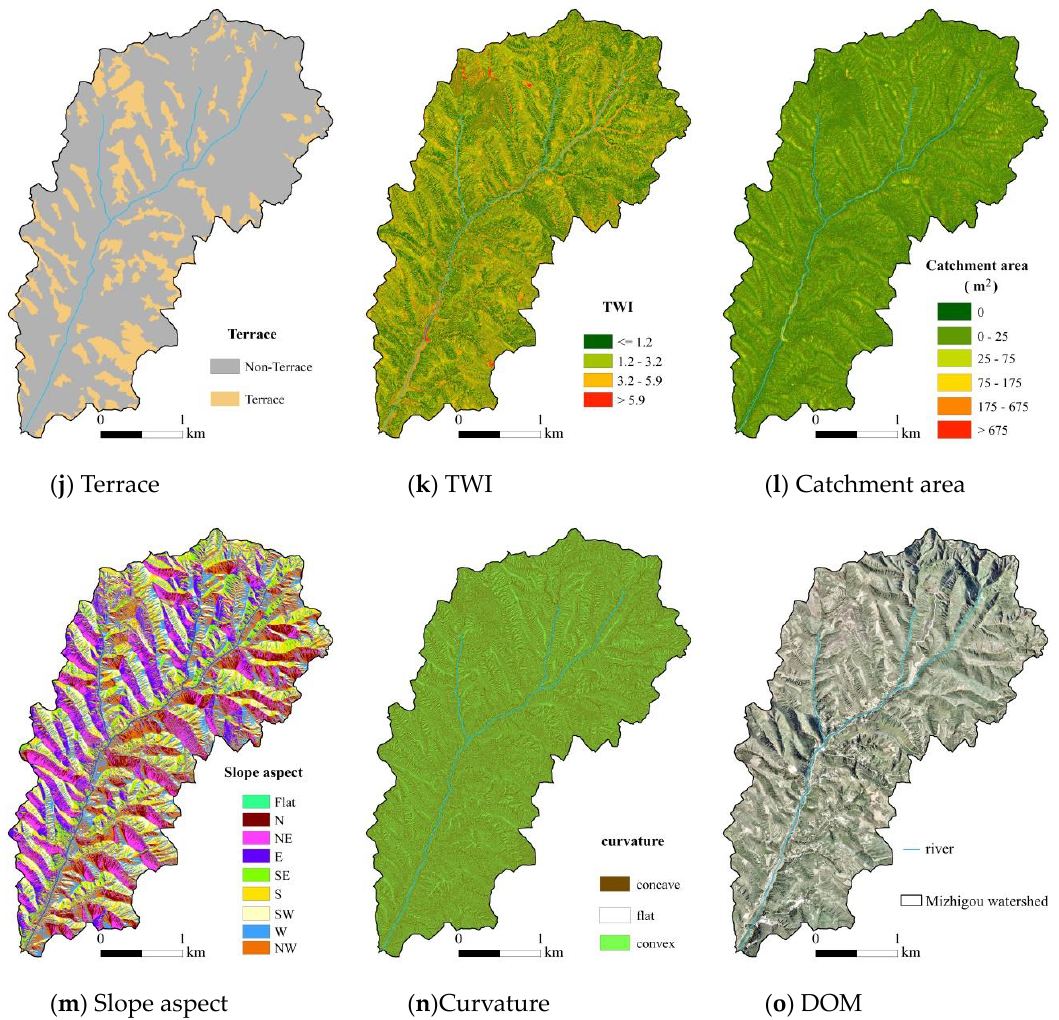
Figure 4. Gully erosion conditioning factors: ( a ) Drainage Density, ( b ) Altitude, ( c ) FVC, ( d ) LS, ( e ) Land use, ( f ) Distance from stream, ( g ) Distance from road, ( h ) Slope gradient, ( i ) SPI, ( j ) Terrace, ( k ) TWI, ( l ) Catchment area, ( m ) Slope aspect, and ( n ) Curvature ( o ) DOM.